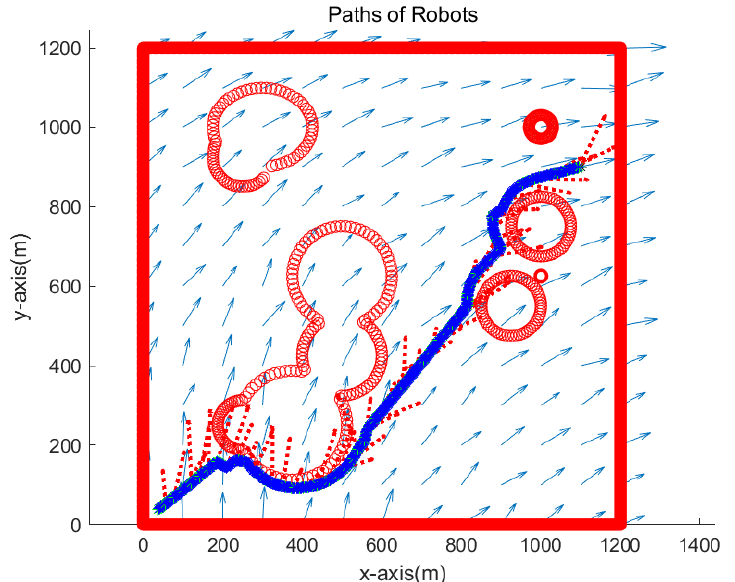
Figure 10. Scenario 2. The path of one robot is depicted with blue asterisks, and that of another robot is depicted with green asterisks. Red dotted arrows show the perturbation vector field estimated at the anchor robot’s